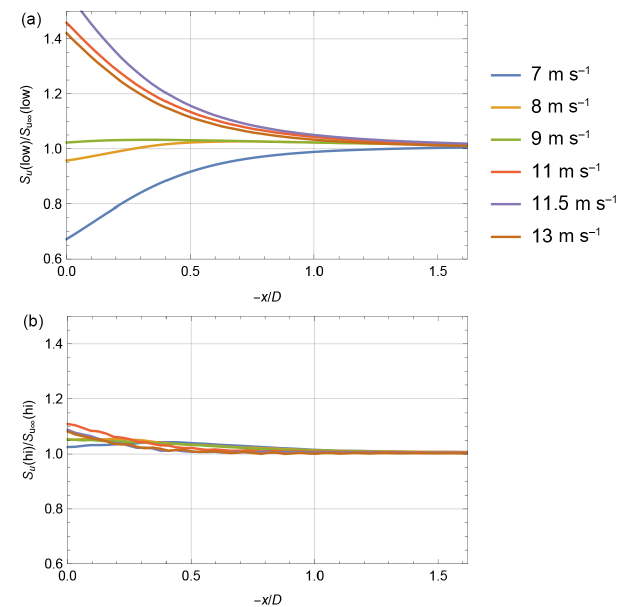
Figure 6. Low-frequency ( f < 0 . 03Hz) and high-frequency ( f > 0 . 03Hz) variances from LES in panels ( a ) and ( b ), respectively.